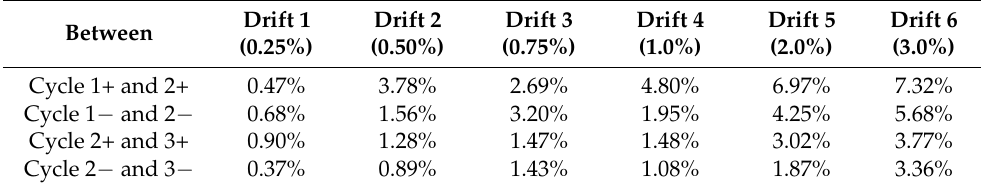
Figure 14. Secant modulus of elasticity-drift diagram—rectangular pier. Table 4. Percentage variation, capacity loss—circular pier.